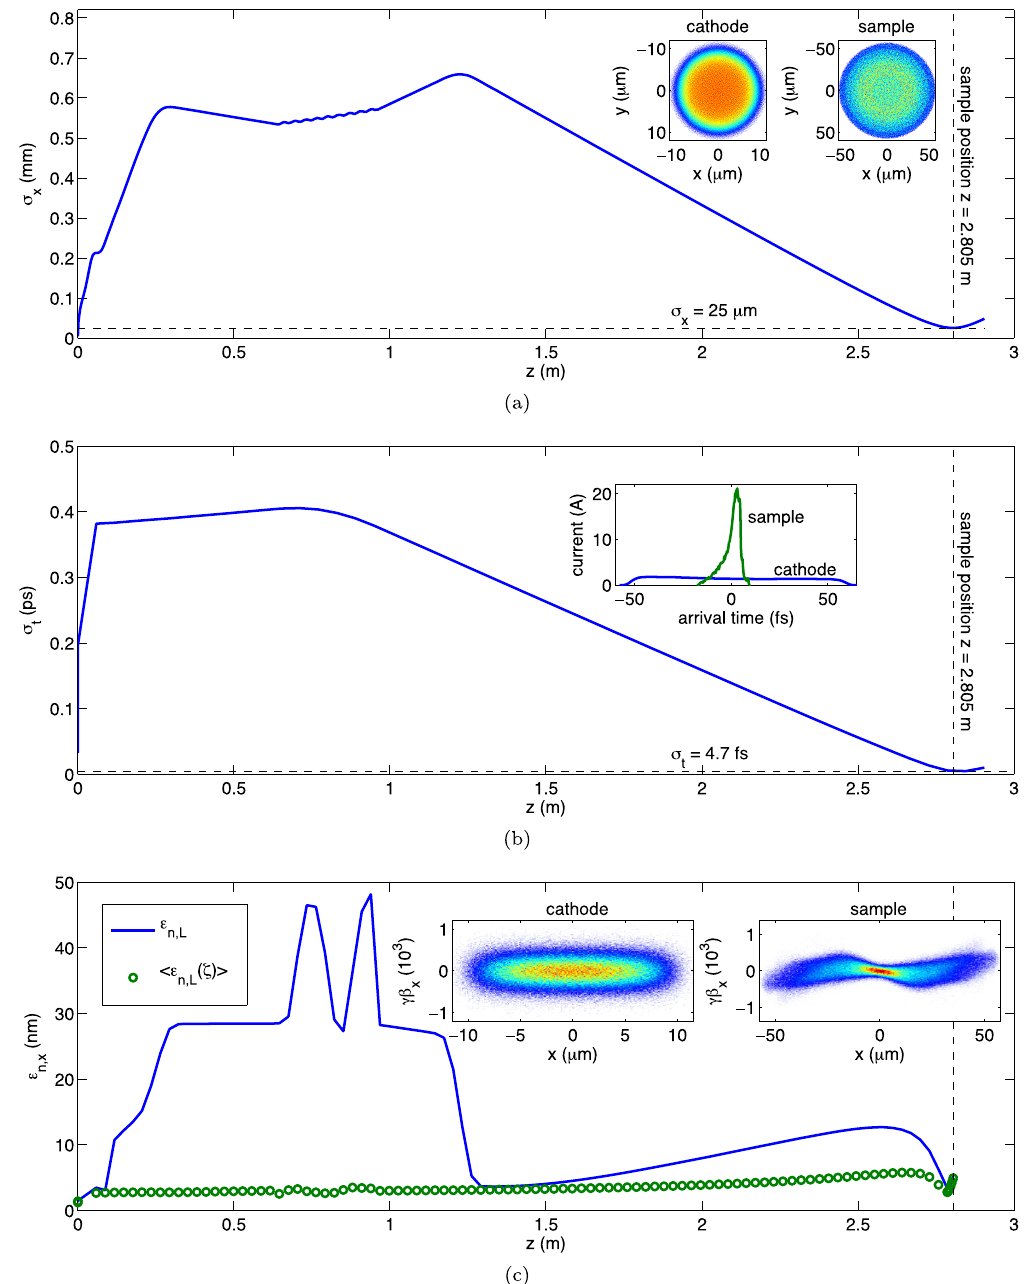
FIG. 6. Transverse (a) and longitudinal (b) rms beam size along the beam line, as well as the transverse emittance (c). Insets show the transverse (a) and longitudinal (b) beam distributions and (c) transverse phase spaces at the cathode and sample